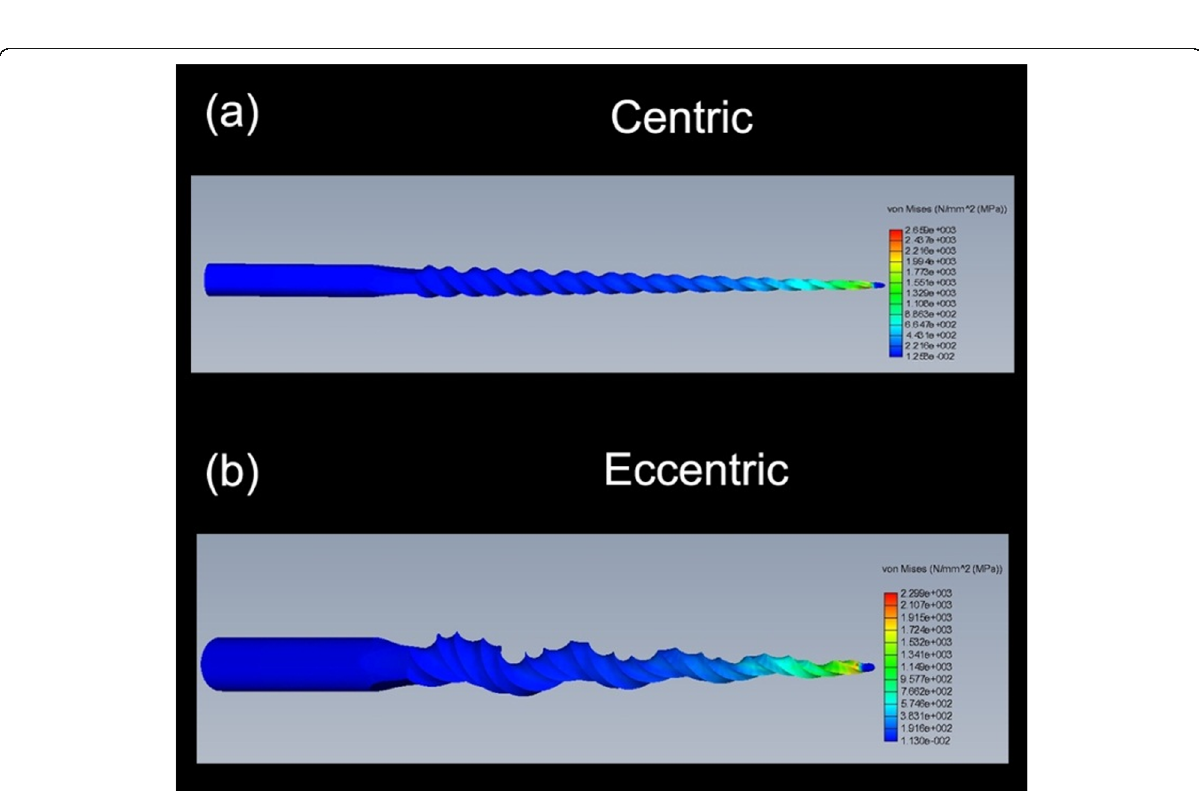
Fig. 10 Stress distribution during torsion of different tested file centricity of the cross-section. a Centric cs. b Eccentric